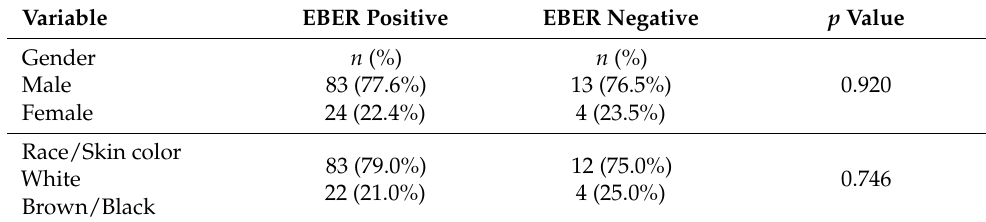
Table 2. Univariate analysis for EBER *